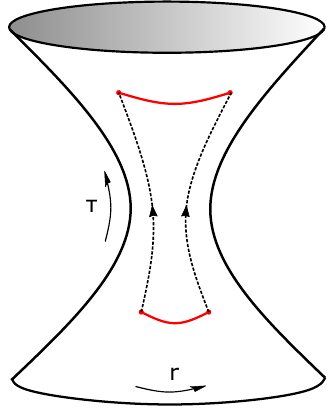
Figure 12 . The hyperboloid represents the de Sitter-like spacetime that arises from the saddle- point solution. Small (cid:13)uctuations of the bi-local collective variables propagate in the spacetime, obeying the dynamics controlled by a local e(cid:11)ective theory. The dashed lines represent the world lines of the end points of the bi-local